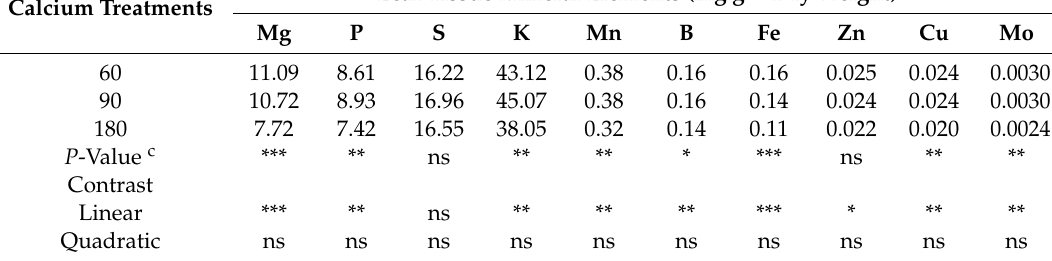
Table 5. Mineral nutrients in leaf tissue of ‘Mt. Fresh Plus’ tomato plants grown in a greenhouse and treated with increasing concentrations of calcium, given as calcium nitrate. Leaf tissue for mineral nutrient analysis was taken above the second cluster for each treatment and replication at 84 d after